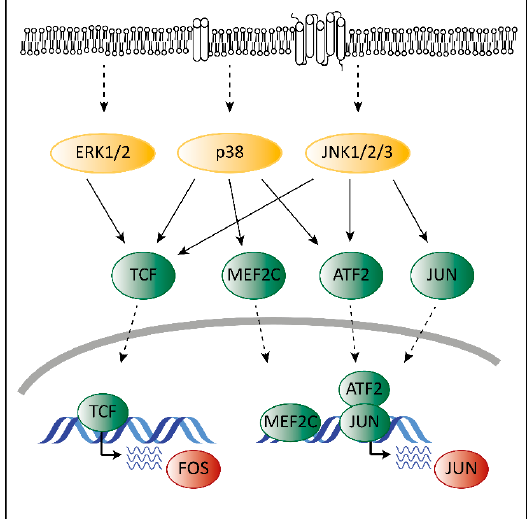
Figure 2. The interplay of CDK4/6 and the MAPK pathways in the context of AP-1. Adapted from [19,41]. Activating signals pass through the MAPK cascade until they reach MAPKs (indicated by the dashed arrows at the top). MAPKs activate ternary complex factors (TCF), MEF2C, ATF2 and JUN (indicated by the arrows) that translocate into the nucleus (indicated by the lower dashed arrows) and induce expression of FOS and JUN .